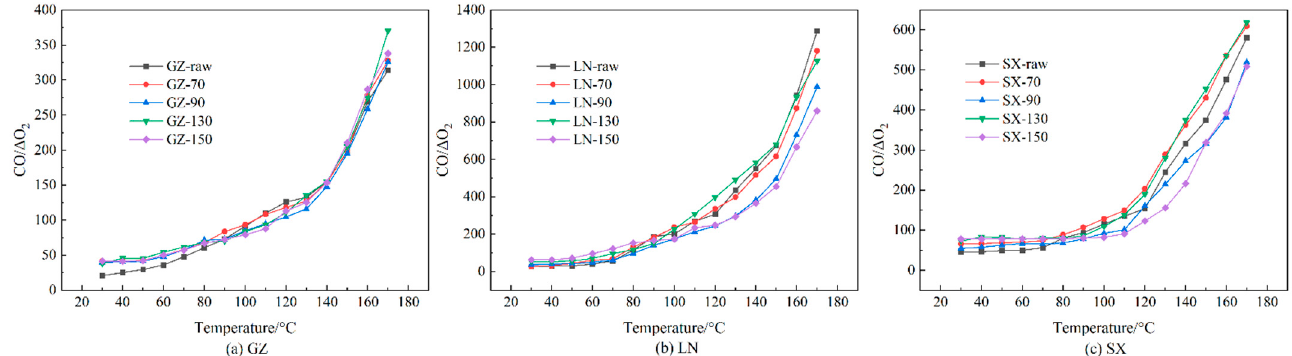
Figure 4. CO concentration at the outlet of the sample reactor: ( a ) GZ; ( b ) LN; ( c ) SX.